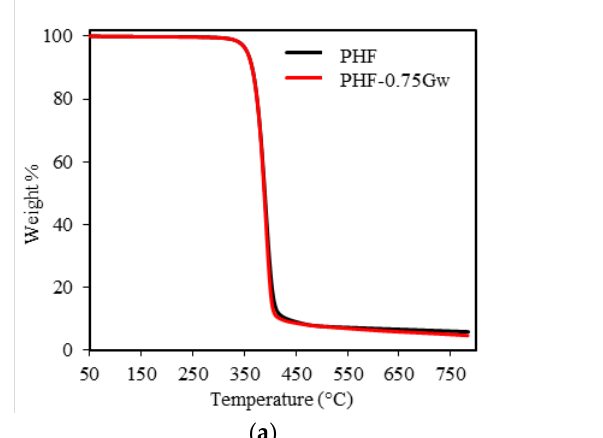
Figure 7. ( a ) Thermogravimetric curves of PPF samples; ( b ) zoomed region.